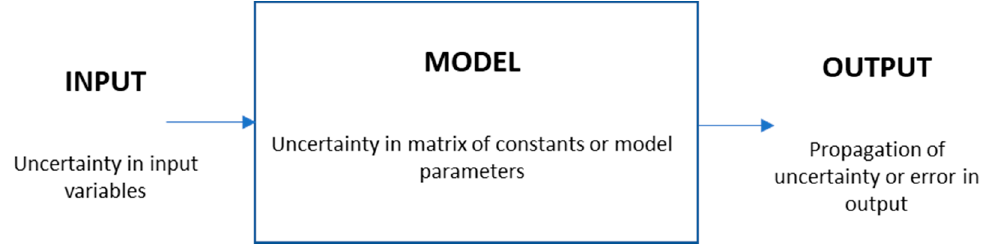
Figure 3. Sources and propagation of uncertainty in modeling techniques.